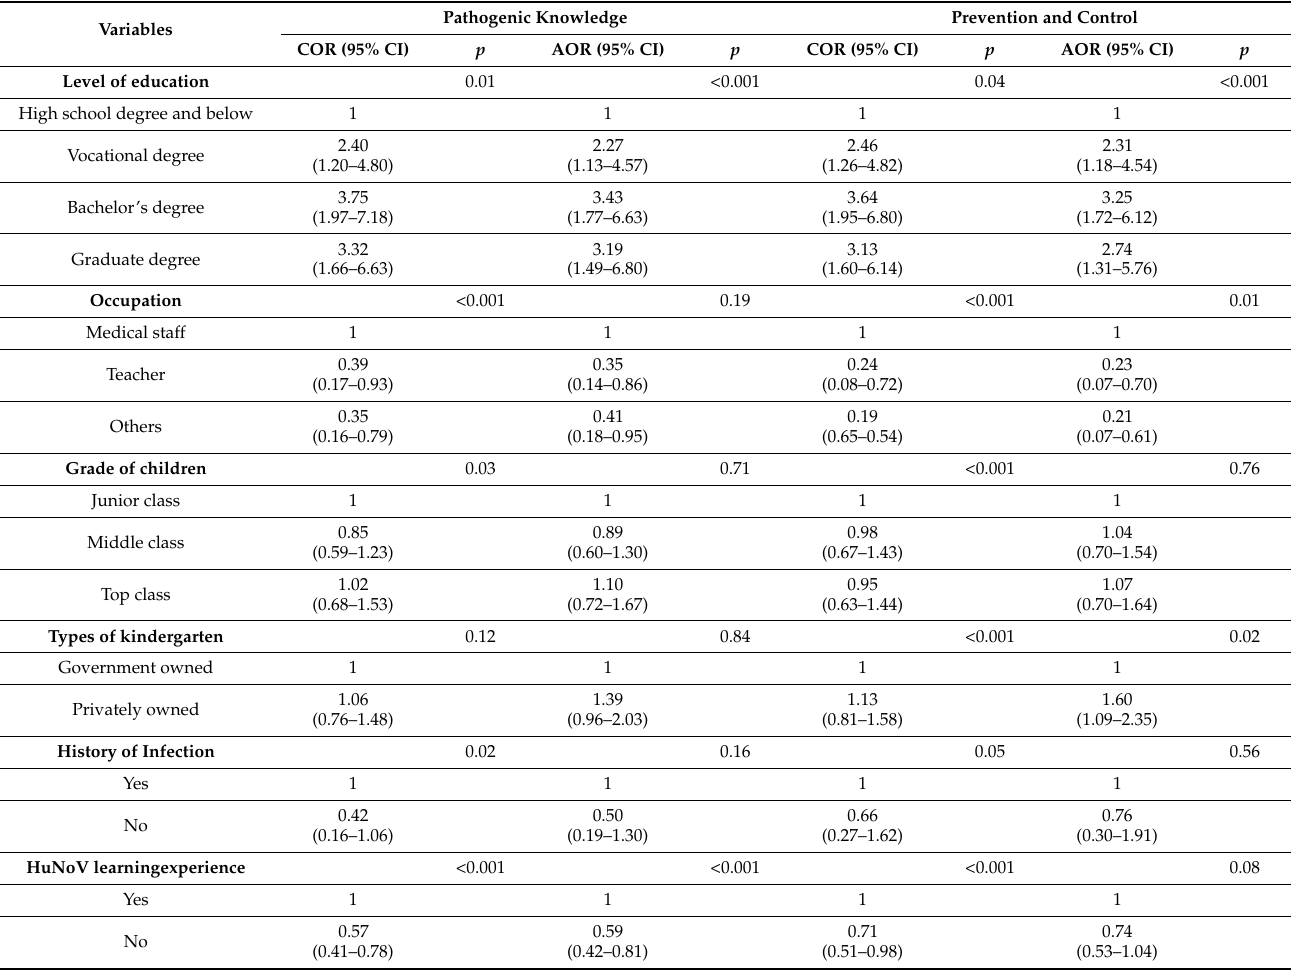
Table 3. Odds ratios of knowledge scores with socio-demographic characteristics (good vs.